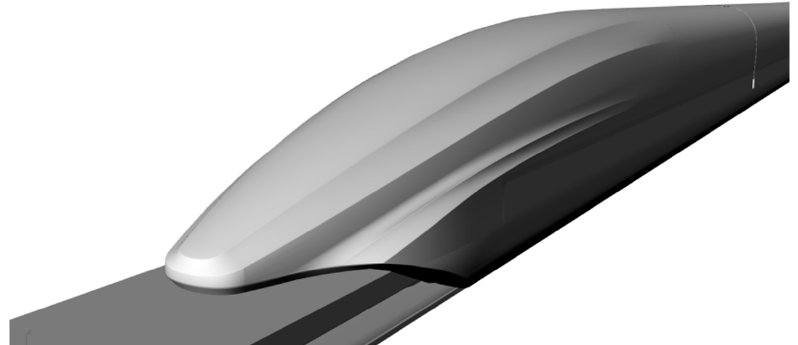
Figure 1. High-speed maglev model.